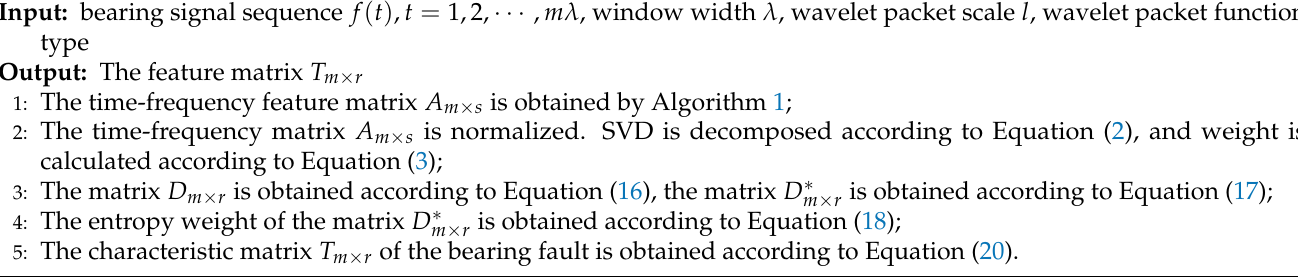
Algorithm 2 Feature extraction method of bearing